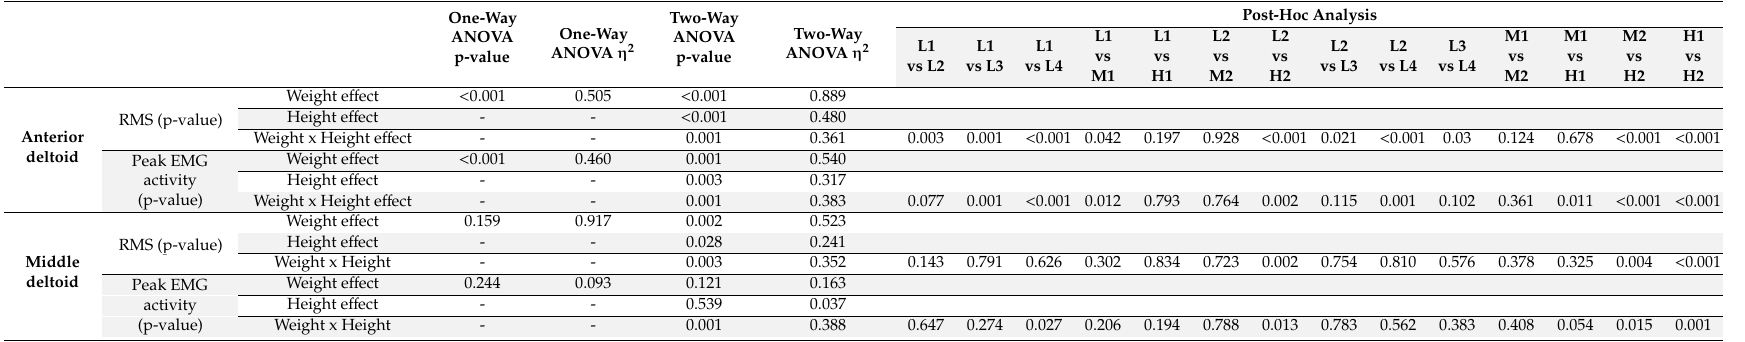
Table 3. Results for anterior and middle deltoids’ EMG activity (p-value and e ff ect size for area under the curve and peak EMG